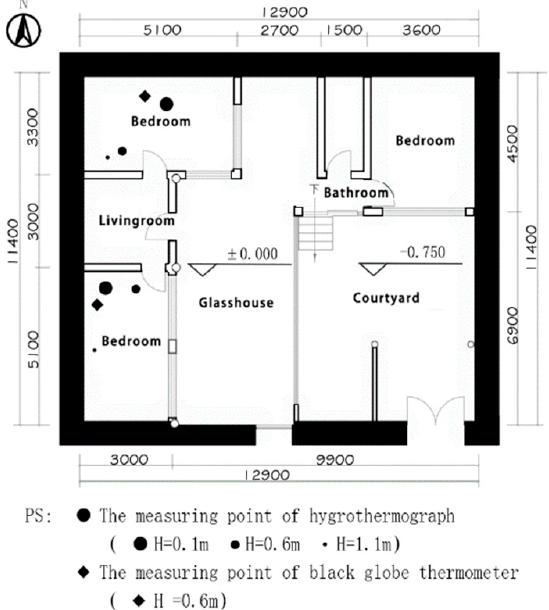
Figure 8. The layout of the measurement locations of the thermal environment parameters (source: self − drawn).